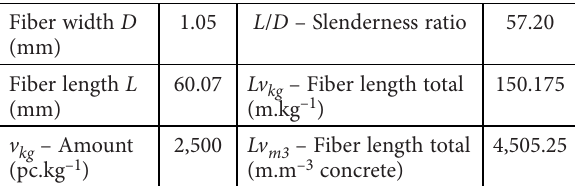
Figure 6. Assigned squares to fibers along the “x”